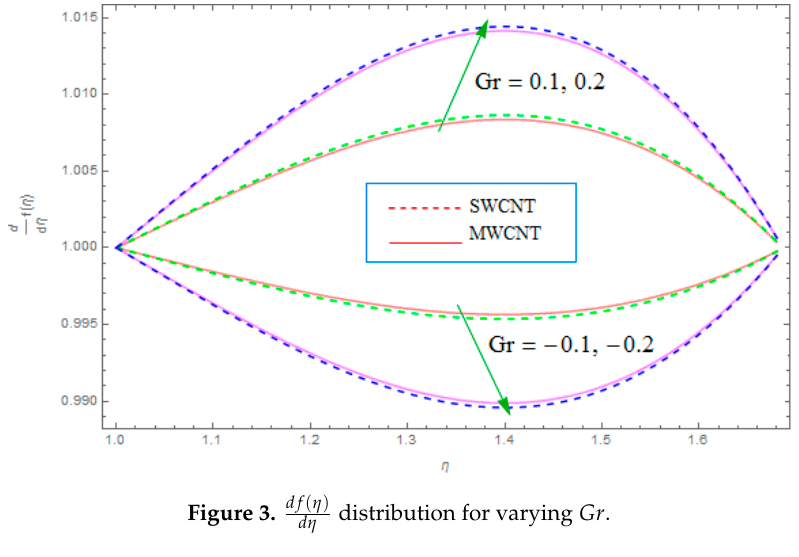
Figure 4 elucidates the behavior of Casson parameter β and nanoparticle volume friction ϕ on